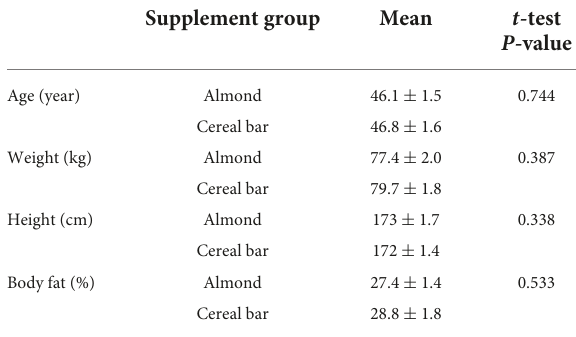
TABLE 2 Subject characteristics for the almond ( n = 33, 20 males, 13 females) and cereal bar ( n = 31, 18 males, 13 females)